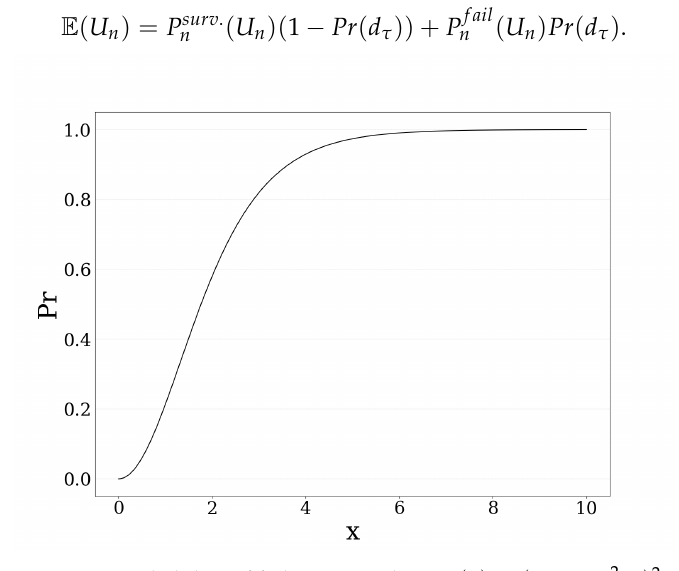
Figure 2. Probability of failure vs x when Pr ( x ) = ( − 1 + 2